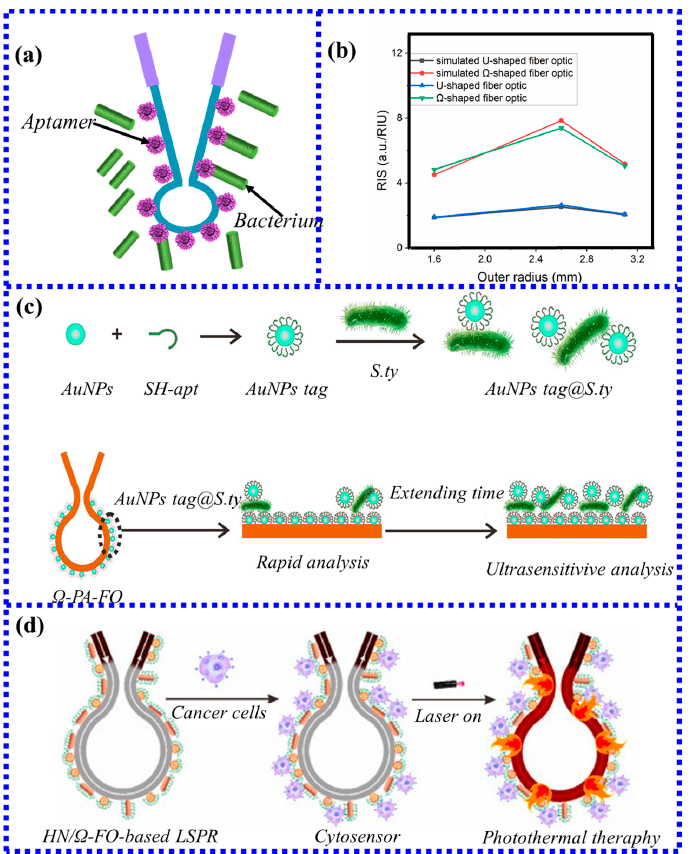
Figure 11. ( a ) Schematic diagram of Ω -type sensing probe; ( b ) The relationship between the outer diameter of U-type fiber and Ω -type fiber and the RI sensitivity [80]. Copyright 2023, Elsevier. ( c ) Schematic illustration of the Ω -FOLSPR for Salmonella typhimurium detection. AuNPs tag is the conjugation of the SH-apt and AuNPs [82]. Copyright 2023, Elsevier. ( d ) Hybridization and plasmonic photothermal treatment [83]. Copyright 2023, Elsevier.